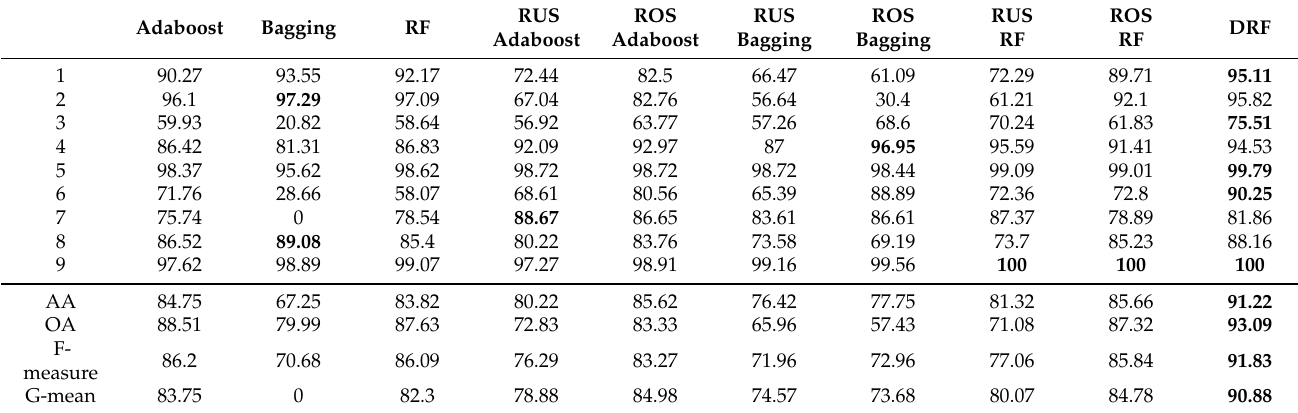
Table 3. Classification results (%) of the University of Pavia ROSIS image, respectively, obtained by Adaboost, Bagging, RF, RUS + Adaboost, ROS + Adaboost, RUS + Bagging, ROS + Bagging, RUS-RF, ROS-RF, and the proposed DRF.